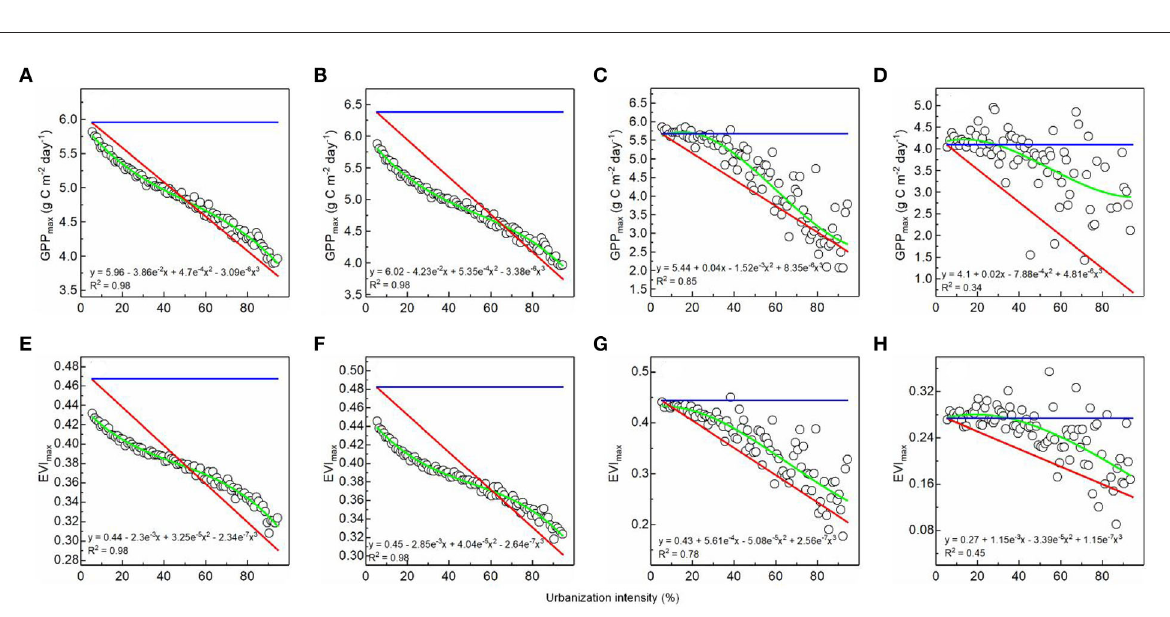
of the GPP max -UI and EVI max -UI relationships among the forest, grassland, and wetland. Specifically, GPP max and EVI max were generally lower than the zero-impact lines for the forest ecosystem but higher than the zero-impact lines for most grassland and wetland ecosystems (Figures 3C,D,G,H), suggesting that the process of urbanization might benefit grassland and wetland vegetation growth in the